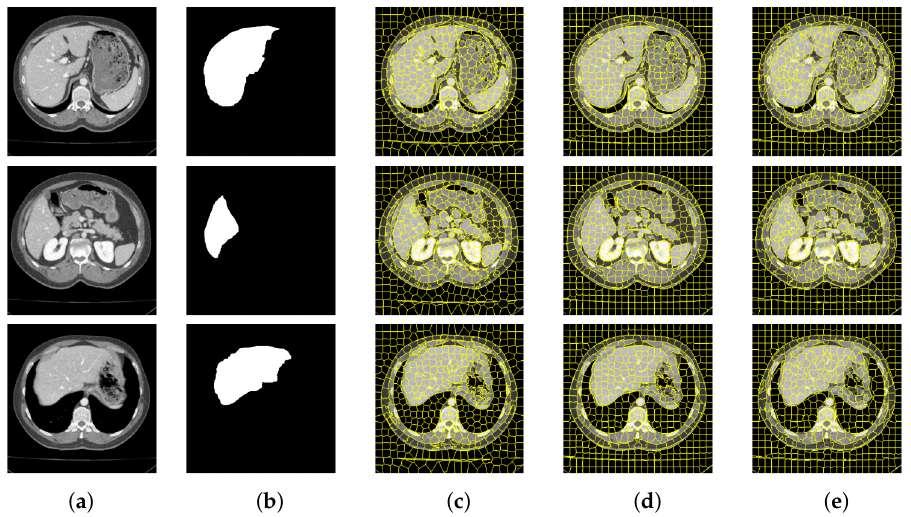
Figure 10. CT image segmentation of liver. ( a ) Original image. ( b ) True image. ( c ) SLIC. ( d ) SNIC. ( e )